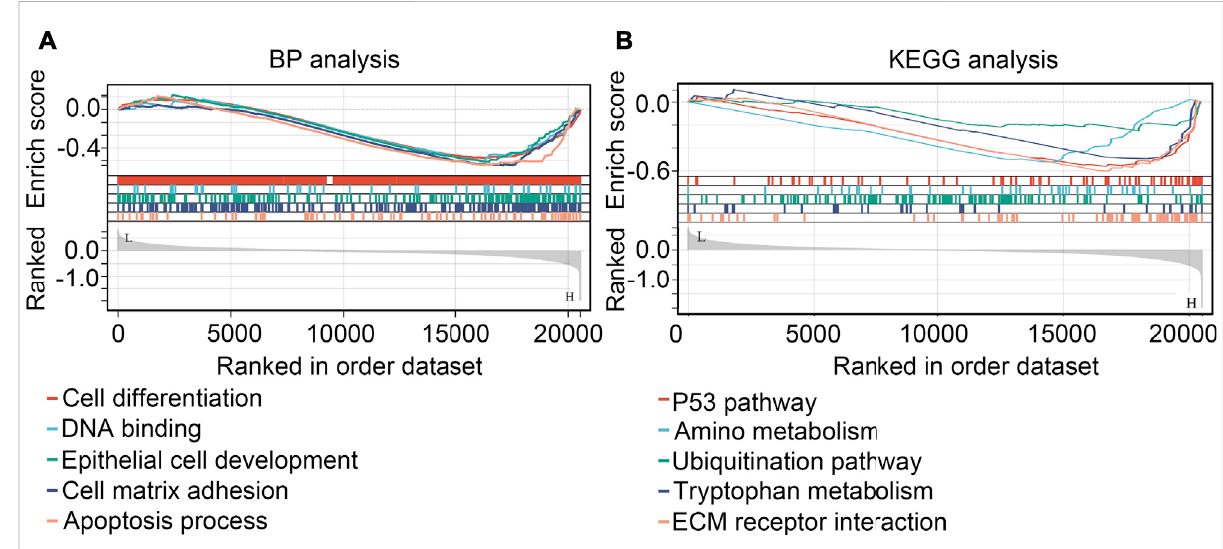
FIGURE 10 GSEA analysis for the biological process terms (BP, (A) and KEGG terms (B) affected by